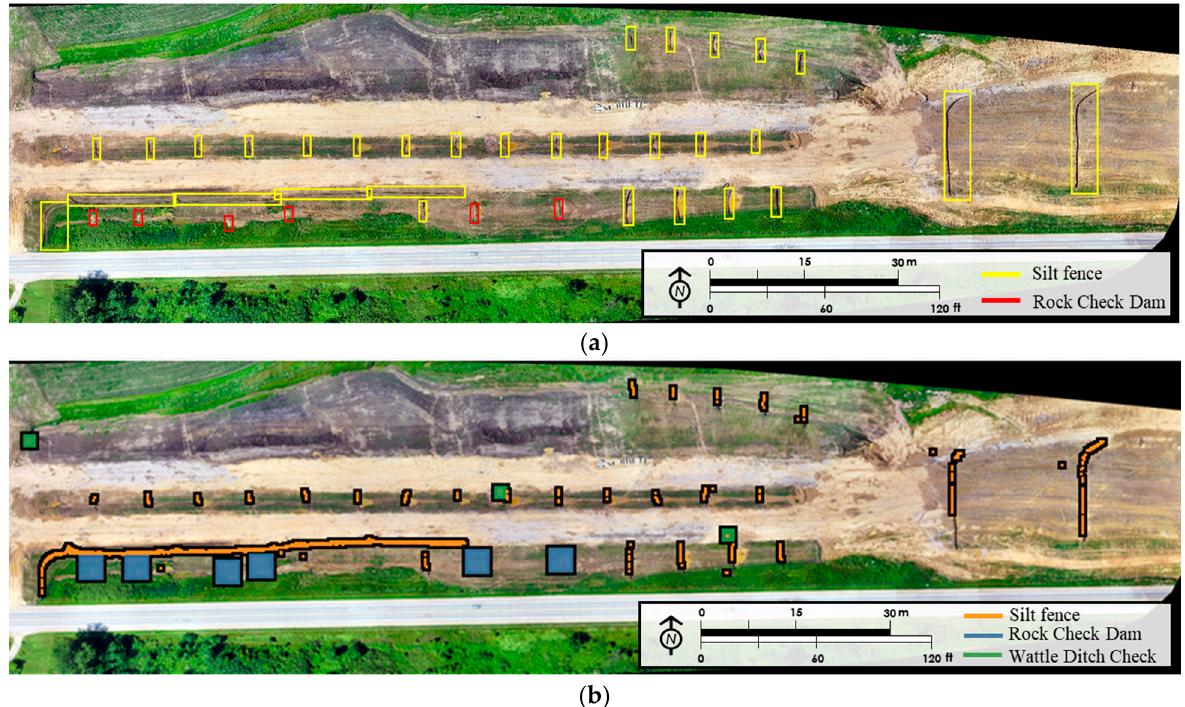
Figure 8. Post-processing results. ( a ) Training layout—18 July 2019; ( b ) result—18 July 2019.